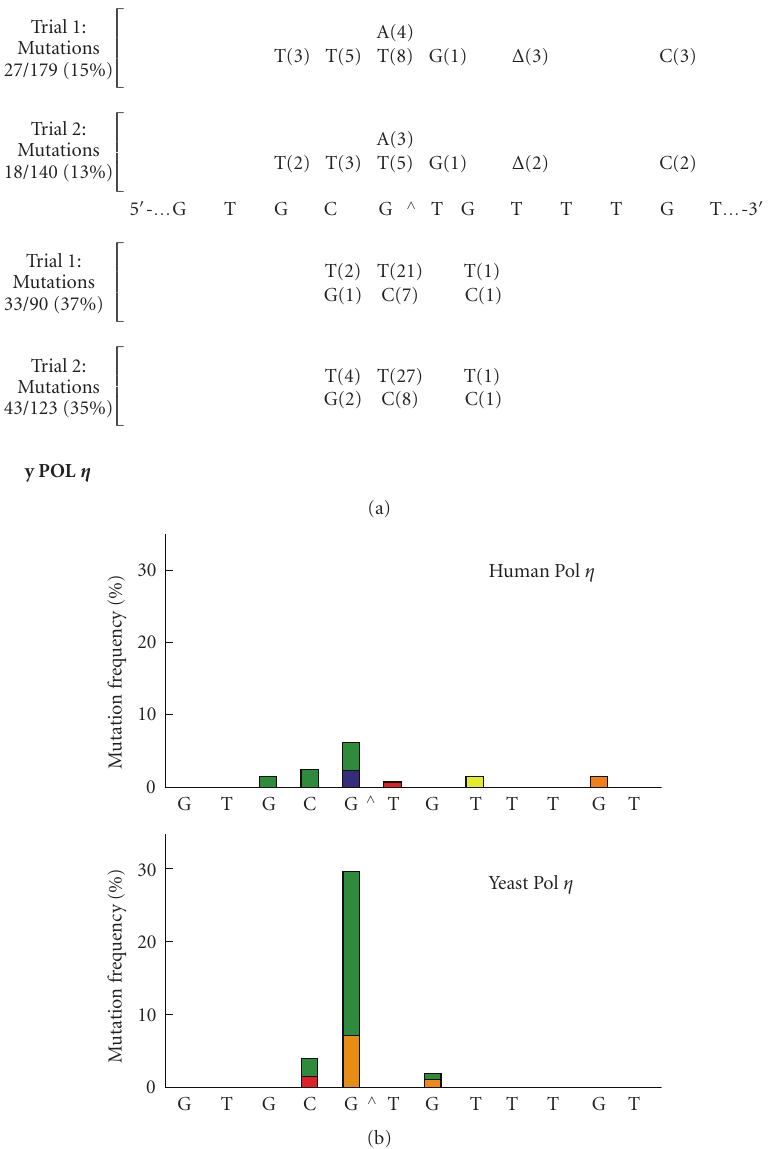
Figure 6: (a) Types and frequencies of mutations induced by G[8,5-Me]T as determined from the full-length extension products generated by hPol η (top) and yPol η (bottom). It is noteworthy that no mutants were isolated from the control batches after sequencing in excess of one hundred colonies. (b) The combined data in (a) is represented in bar graph showing the percentages of each type of single-base substitution or deletion induced by G[8,5-Me]T by hPol η (top) and yPol η (bottom). The colors represent T (green), A (blue), G (red), C (orange), and one-base deletion (yellow). The T deletion in a run of three thymines by hPol η was arbitrarily shown here at the T closest to the lesion. 3 (cid:4) -end of the plasmid to fill in the gap, which is then enzymatically ligated to create a closed-circular plasmid or viral genome. The ss circular DNA is replicated in